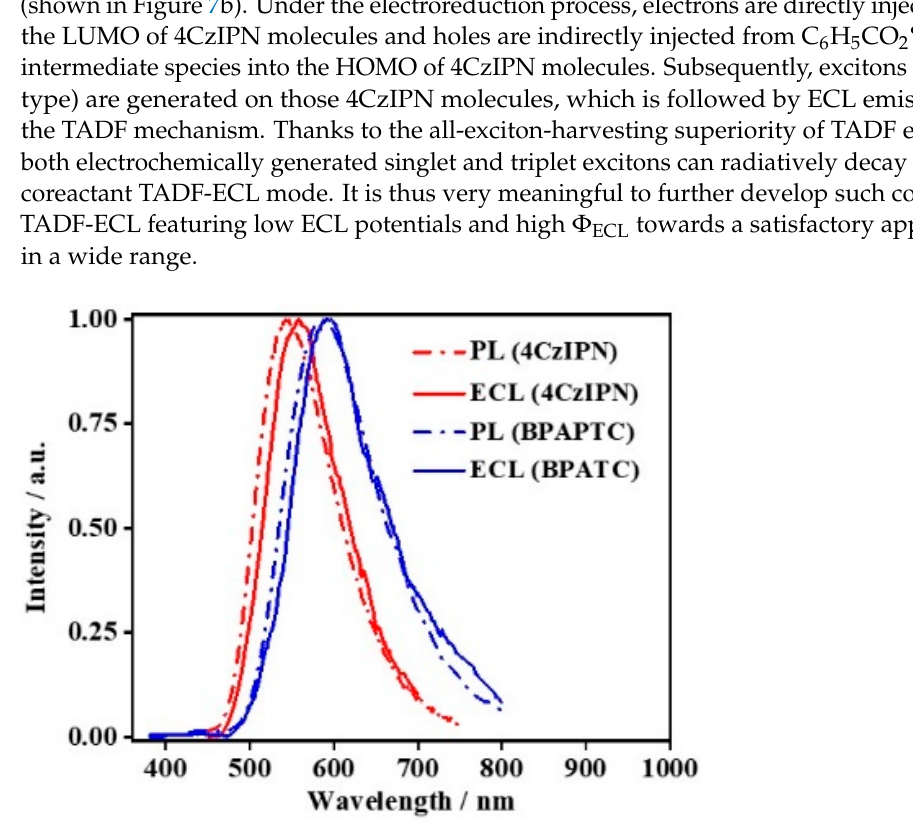
Figure 6. PL Spectra of 0.1 mM 4CzIPN or BPAPTC in DCM (dash line) and ECL spectra of 0.1 mM 4CzIPN or BPAPTC in DCM (solid line).